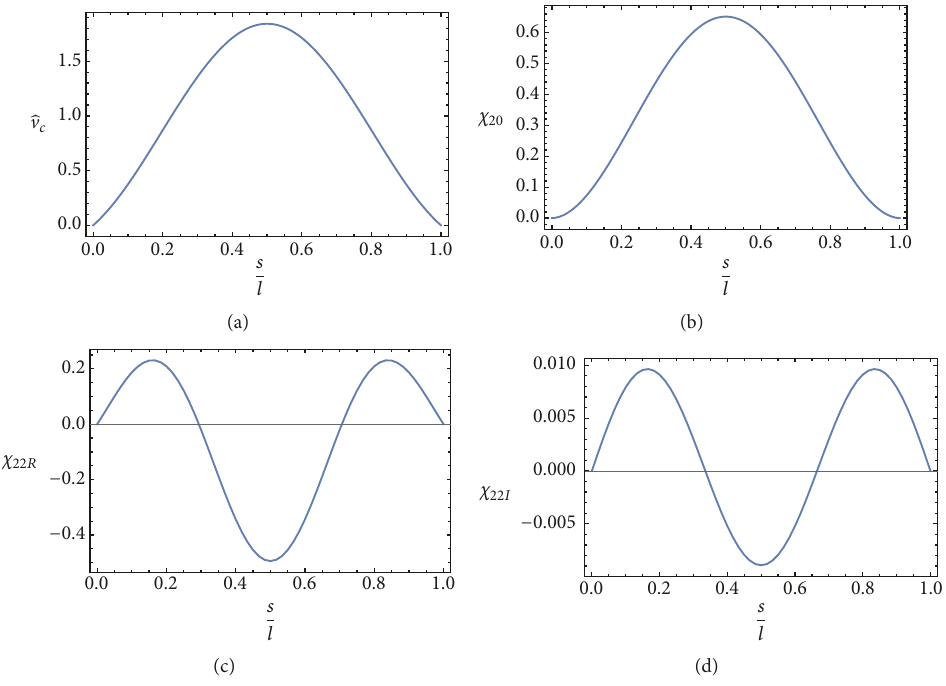
Figure 2: Case-study 1: symmetric mode and second order corrections.